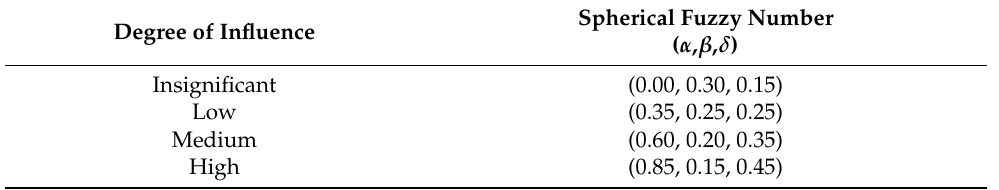
Table 2. SF DEMETAL linguistic scale